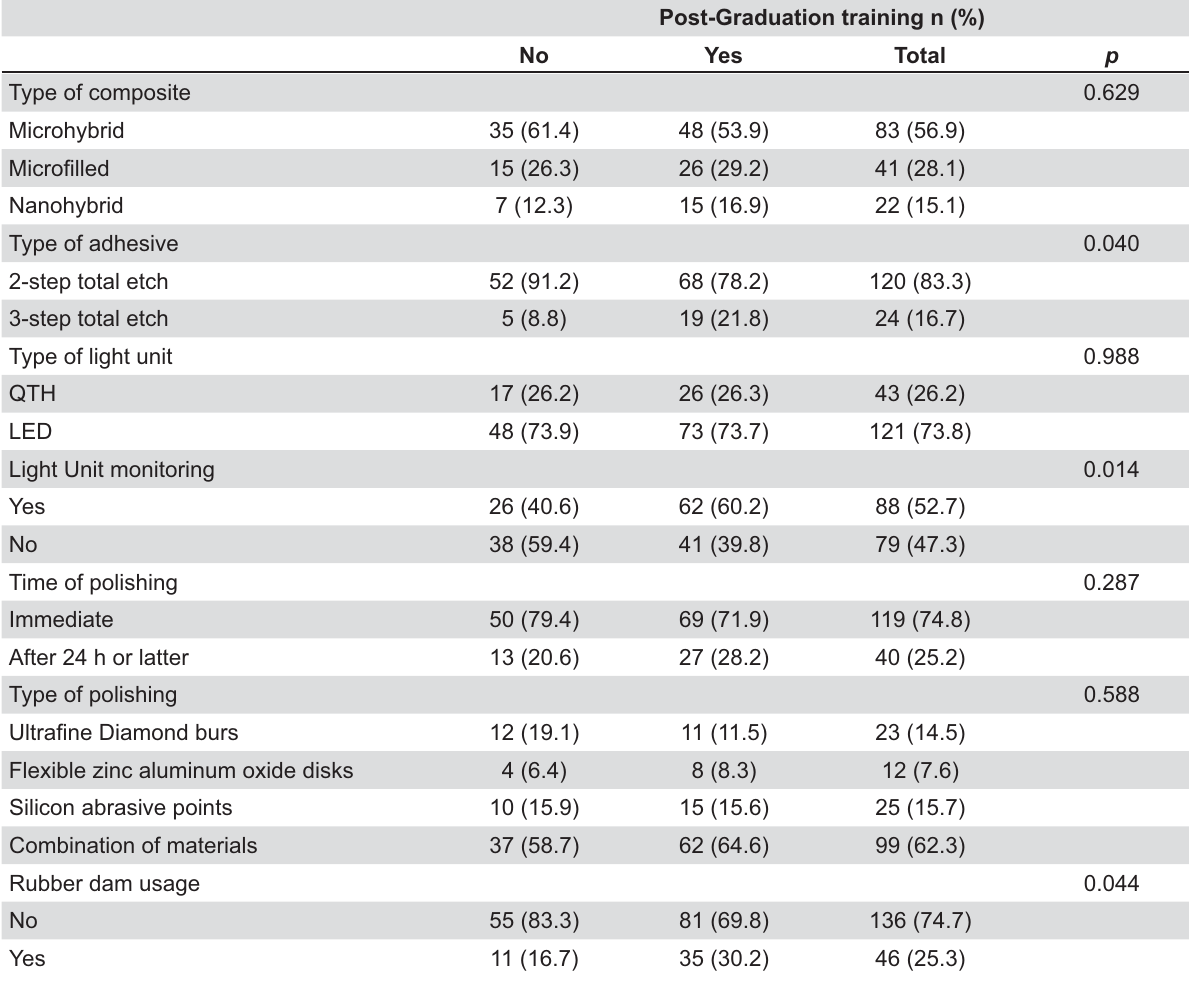
Table 3- Association between the post-graduation training of dentists and variables related to practices for anterior composite